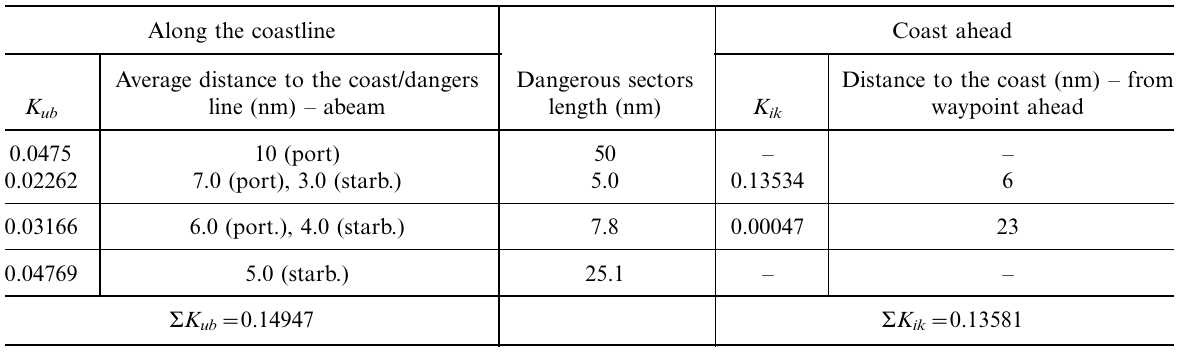
Table 1. Route I (257 nm)